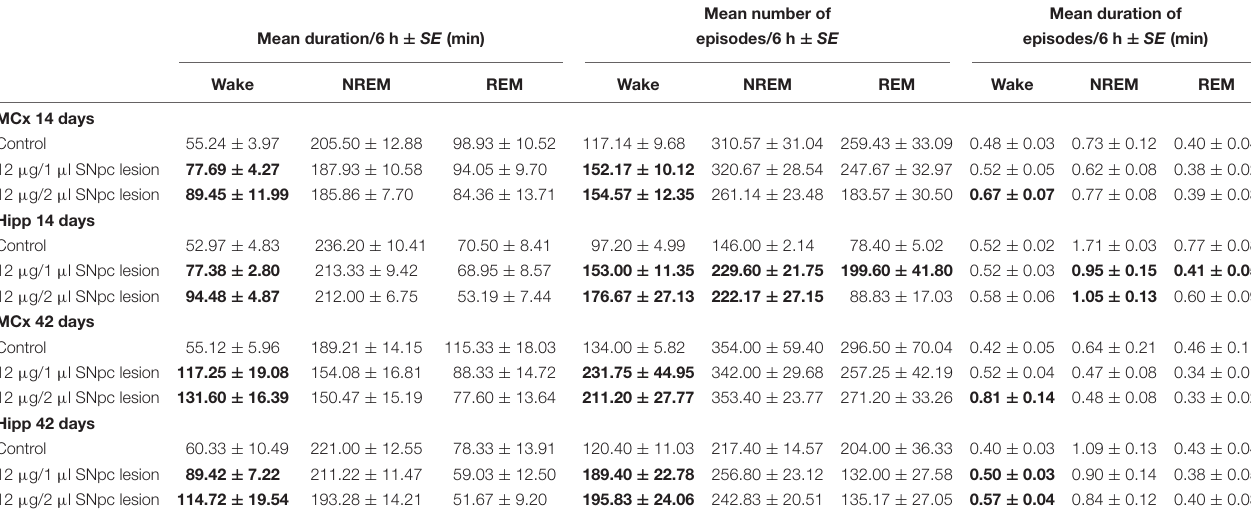
TABLE 1 | The impact of SNpc dopaminergic neuronal loss on the Wake/NREM/REM durations and their episode dynamics at 14 and 42 days following the SNpc lesions vs. controls in the motor cortex (MCx) and hippocampus (Hipp): the mean duration of Wake/NREM/REM sleep (minutes) with the mean numbers and mean durations (minutes) of the Wake/NREM/REM episodes per 6 h of sleep ± SE. Mean number of